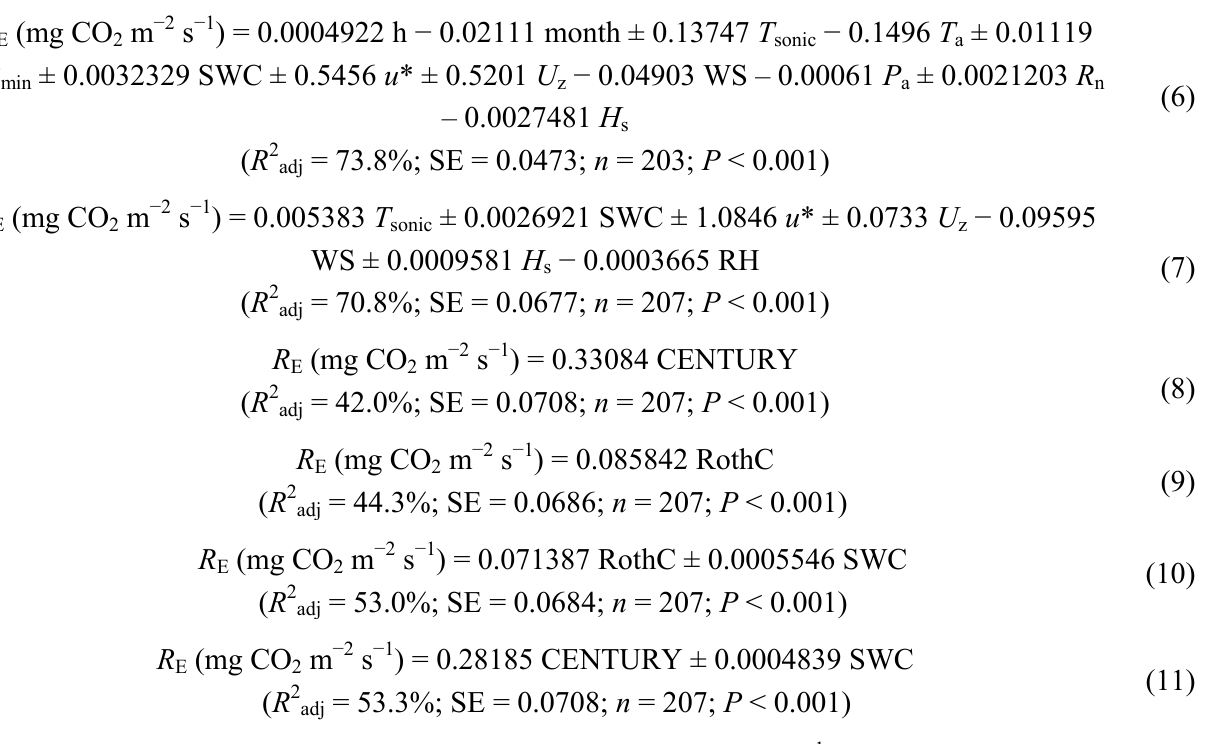
components for the Yenicaga peatland based E E